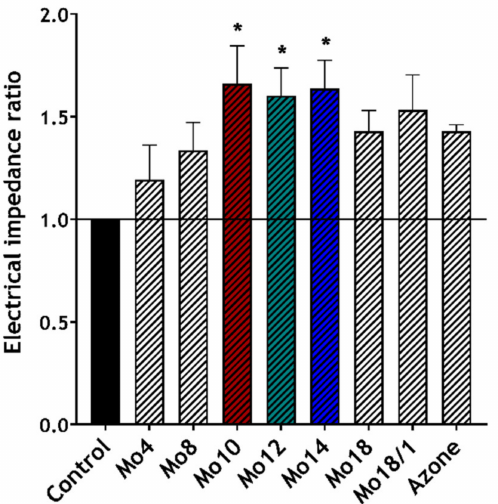
Figure 2. Effects of the studied enhancers (1%) on the skin electrical impedance ratio (EIR). Mean ± SEM, n ≥ 12; * Statistically significant difference compared to the negative